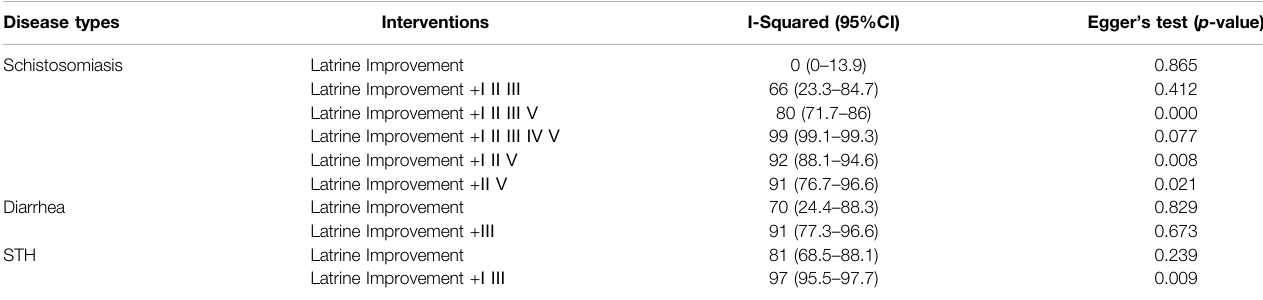
TABLE 3 | Overview of eligible records with latrine improvement and other intervention. Disease